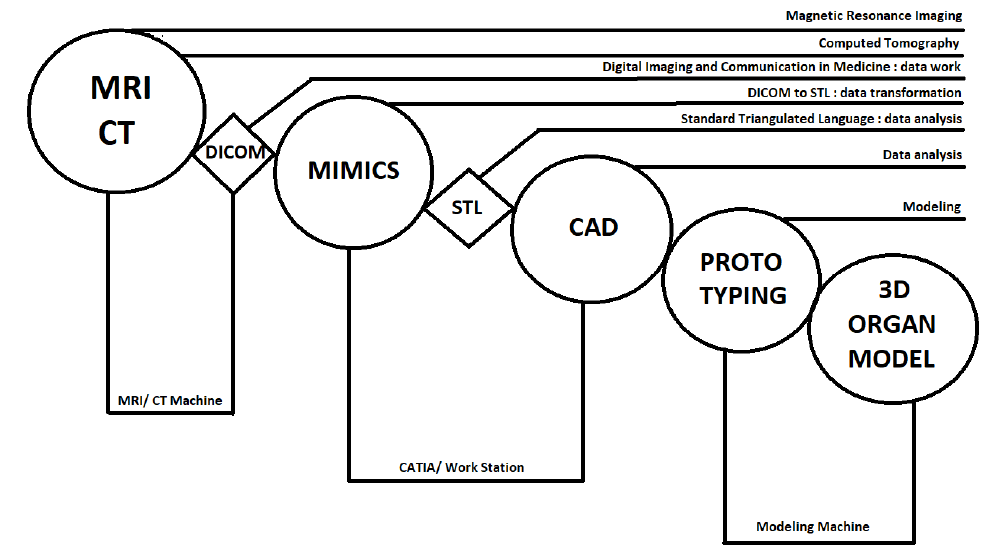
Figure 10. Technological process of a 3D-printing production applied in regenerative medicine [80].